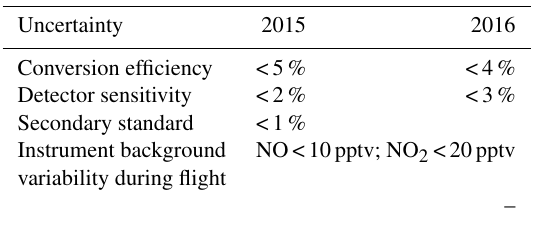
Table 4. Overview of the calibration uncertainties for the two de- ployment phases in 2015 and